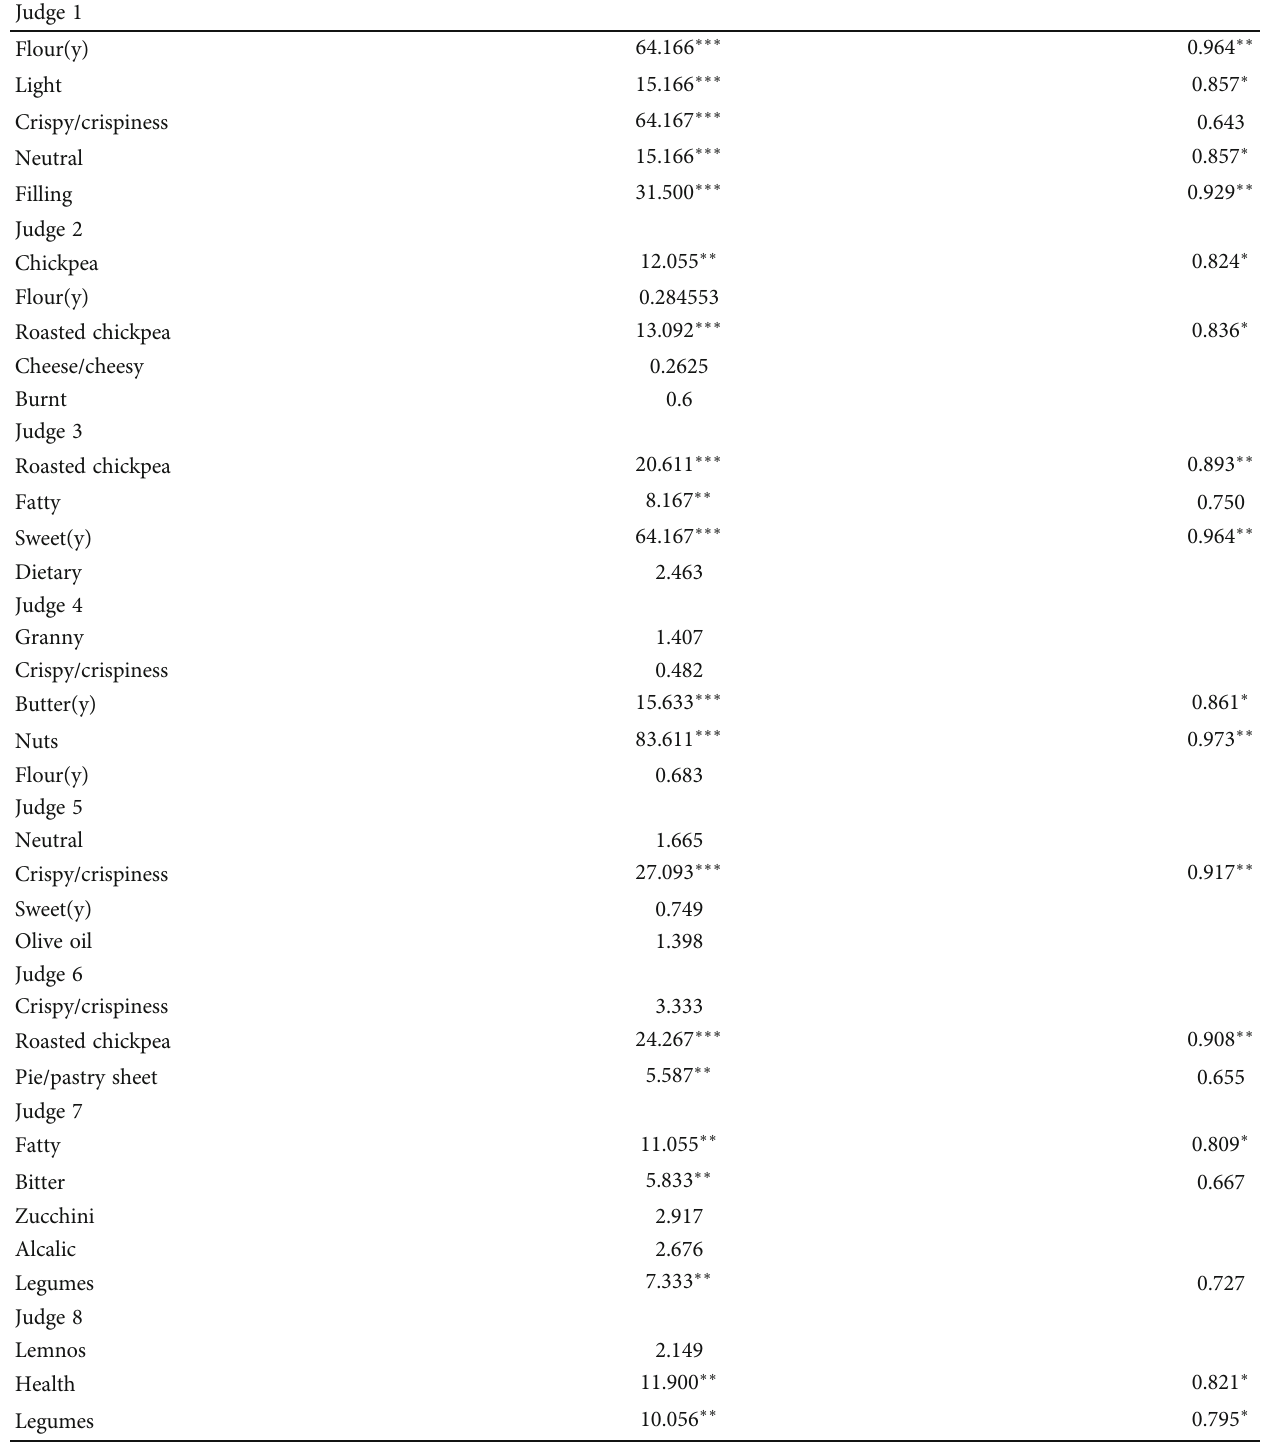
Table 4: F -values ( P < 0 : 05 for ANOVA) and SCC values ( P < 0 : 05 ) for Spearman ’ s correlation test on sensory attributes from each Greek judge in the Flash pro fi